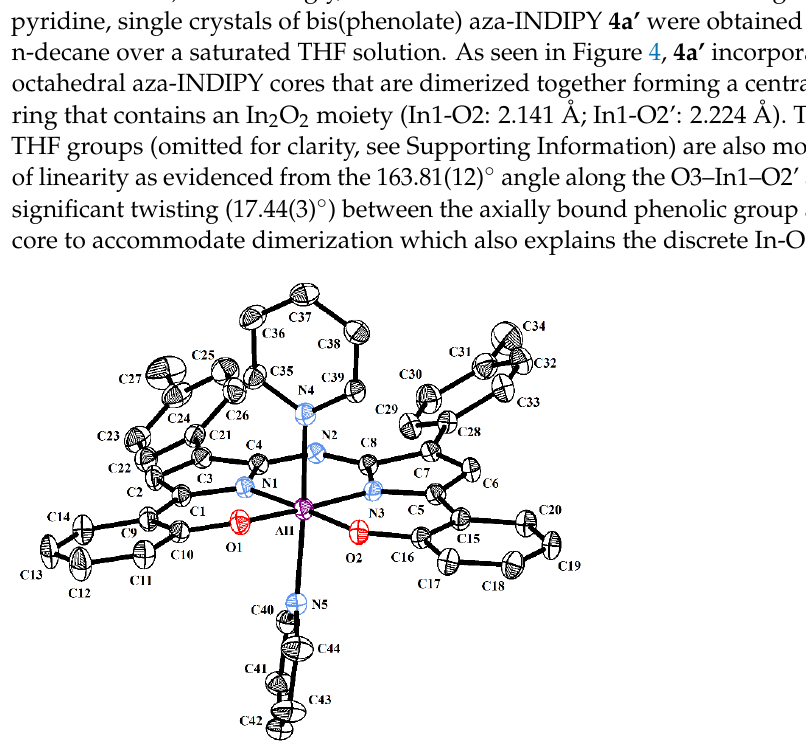
Figure 3. Molecular structure of 2a . Ellipsoids are drawn at the 40% probability level. Hydrogen atoms have been removed for clarity.